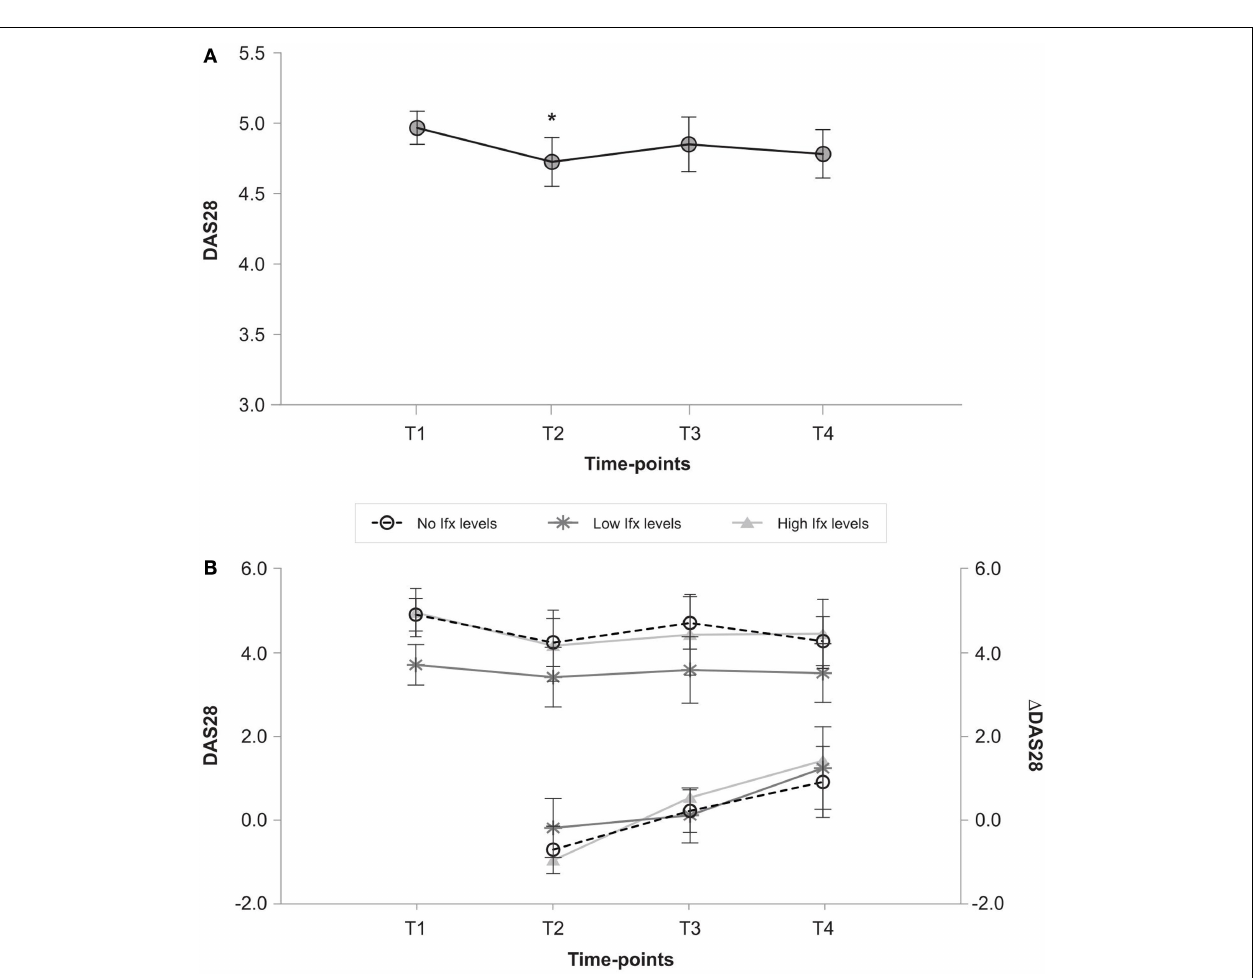
FIGURE 1 | (A) Changes in DAS28 over time in all patients. T1 (baseline), T2 (post-Ifx dose increment), T3 (at 6months), T4 (at 12months). * p < 0.05 vs. DAS28 in T1 after Bonferroni correction. (B) DAS28 and delta-DAS28 from T1 in patients with no, low and high Ifx serum concentrations at baseline. T1 (baseline), T2 (post-Ifx dose increment), T3 (at 6months), T4 (at 12months).